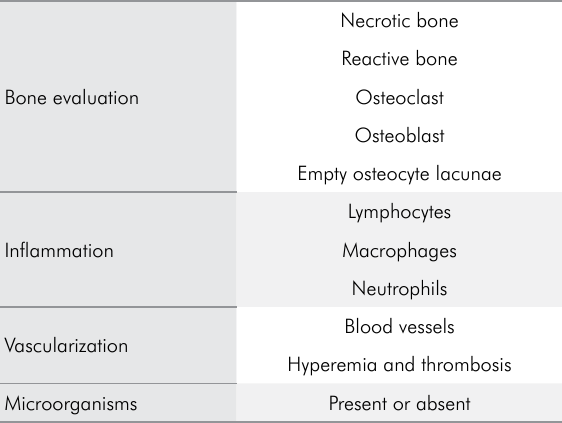
Table 1. Microscopic evaluation